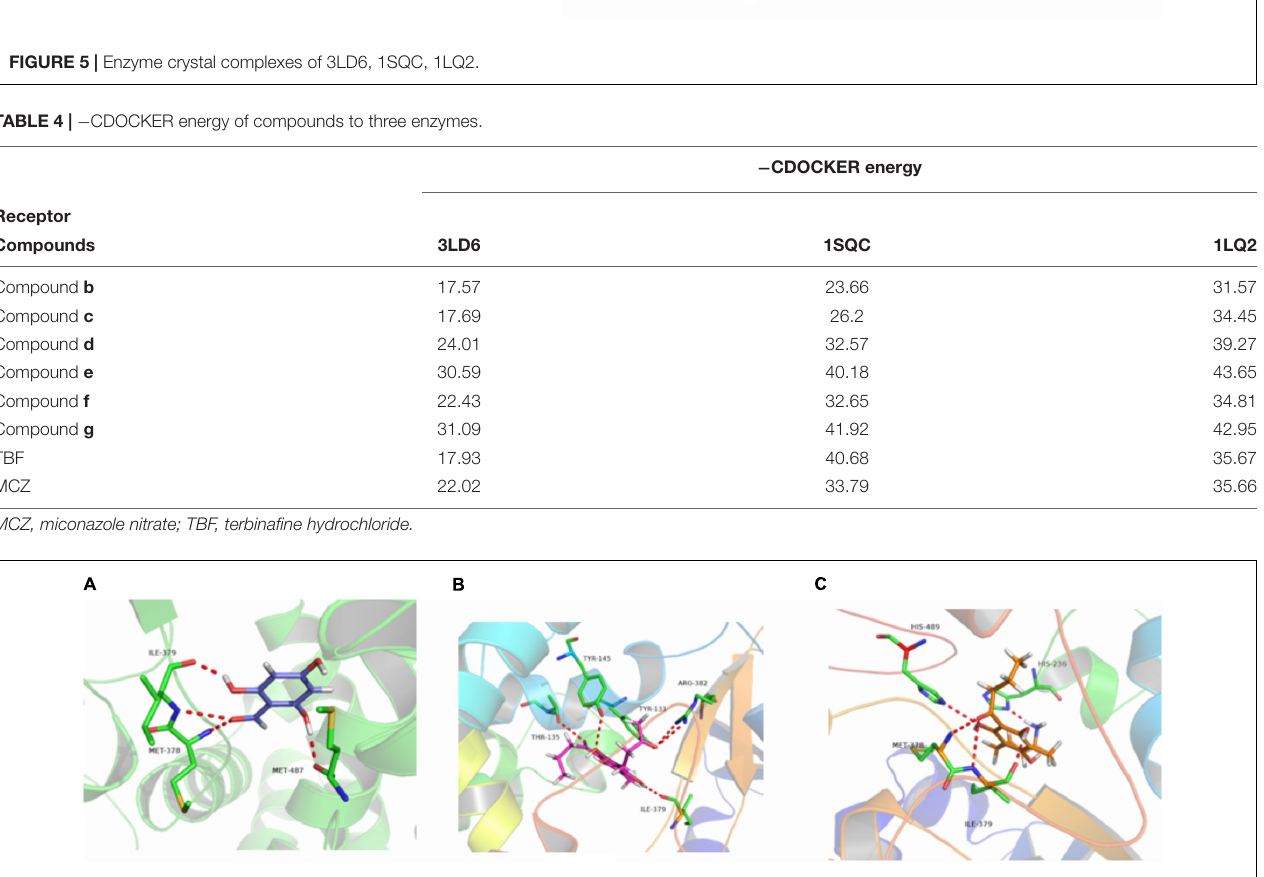
FIGURE 6 | 3D docking conformation of compounds with 3LD6: (A) 3D docking conformation of compound b with 3LD6; (B) 3D docking conformation of compound e with 3LD6; (C) 3D docking conformation of compound g with 3LD6.